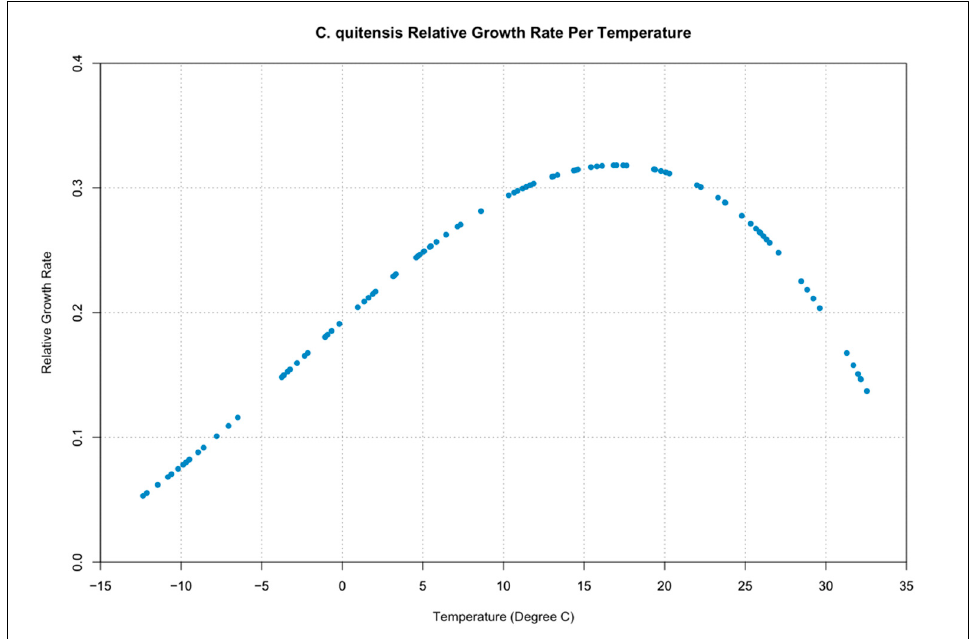
Figure 11. C. quitensis Relative Growth Rate Per Temperature.